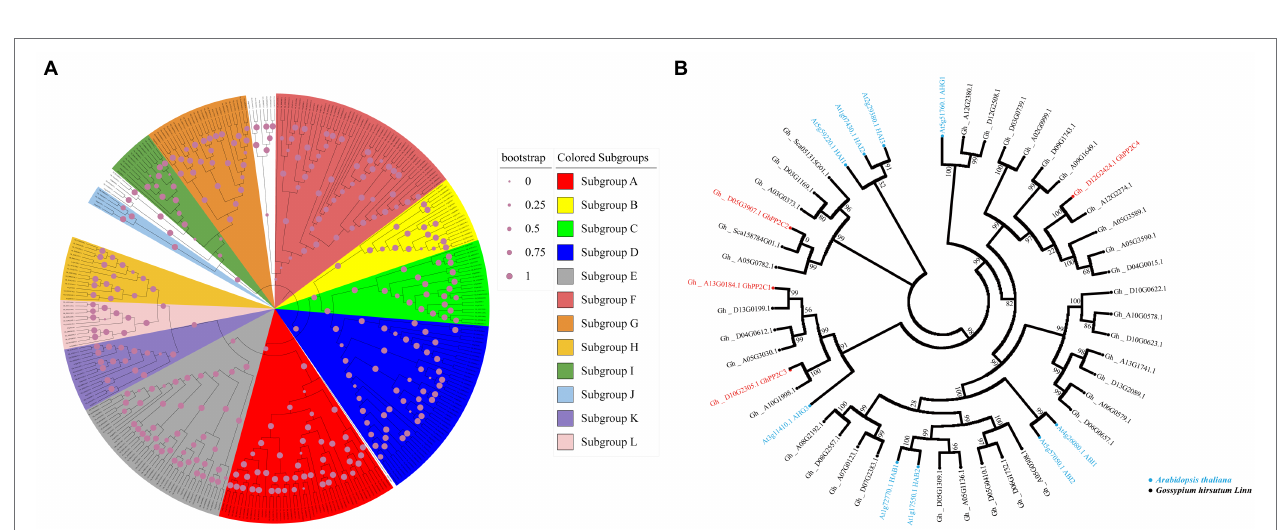
FIGURE 3 | Phylogenetic relationships among PP2C family members. (A) Phylogenetic tree for PP2C family members of upland cotton and Arabidopsis. Sequences for PP2C family members of Arabidopsis were obtained from TAIR (http://www.arabidopsis.org). Subgroups A–L are as delimited in a previous study (Fuchs et al., 2013). Different subgroups are indicated by different colors. (B) Phylogenetic tree for subgroup A PP2C family members of upland cotton and Arabidopsis . Blue and black indicate Arabidopsis and upland cotton, respectively; red indicates the four GhPP2C genes detected in the transcriptome data. The evolutionary tree was constructed using the neighbor-joining method with MEGA7. The values at the nodes are bootstrap support percentages ( n = 1,000